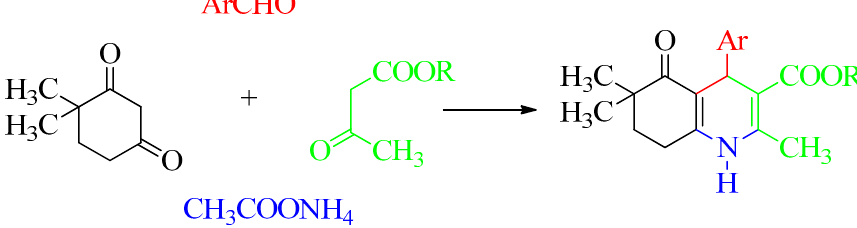
Figure 9. Synthetic scheme for the preparation of newly synthesized DHPs.